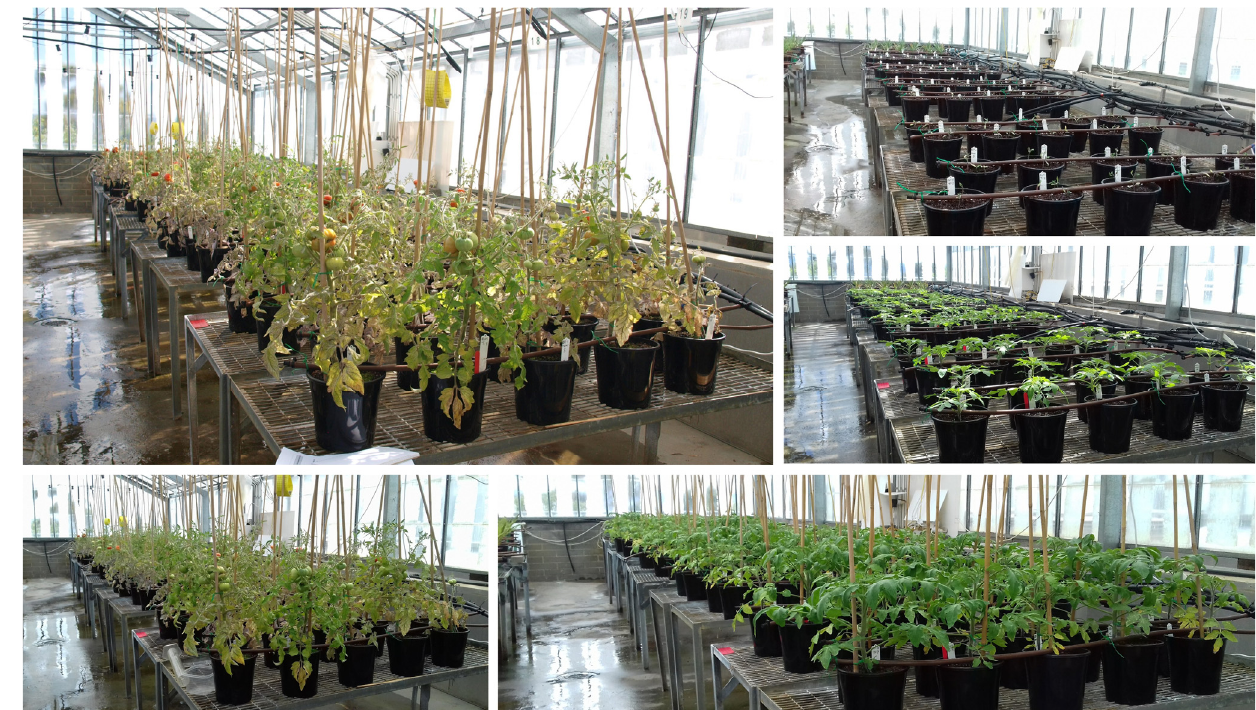
Figure 1. Experimental set up of tomato plants in greenhouse pot trial with UWP addition treatments and Hoagland control. Clockwise the five photos shows five stages of plant growth, from seedlings transplant to tomato fruit maturation.